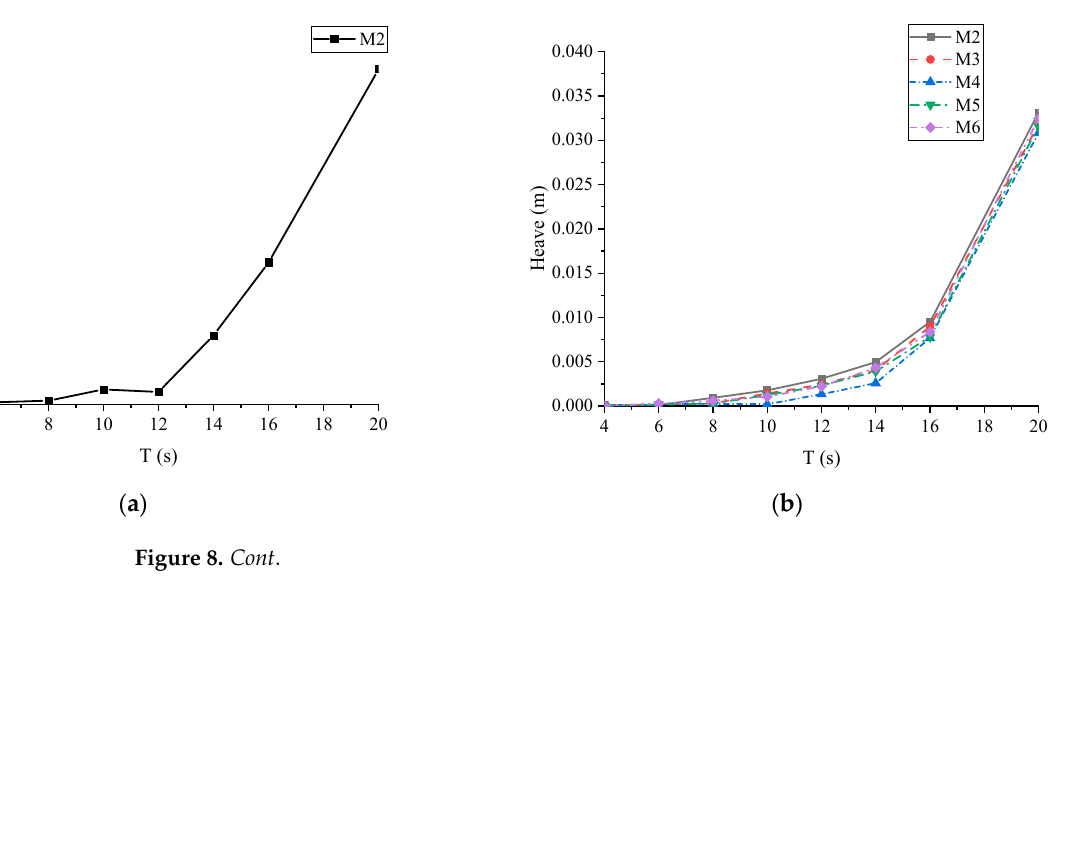
Figure 7. Effects of incident wave directions on WECs’ performance: ( a ) pitch; ( b ) average output power.